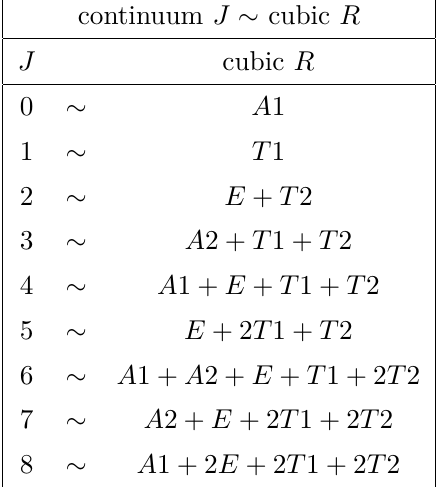
Table 2 . Projection of continuum spin J states onto the cubic representations R